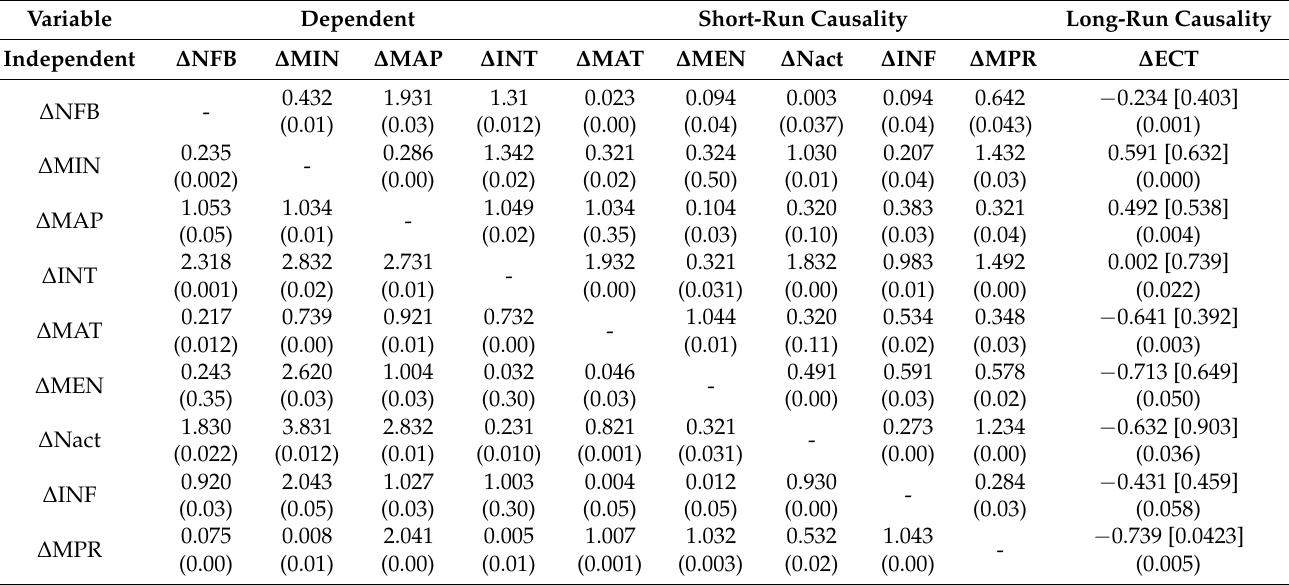
Table 6. Vector Error Correction Model (VECM) Granger causality analysis (Jiangsu Province). Dependent Short-Run Causality Long-Run